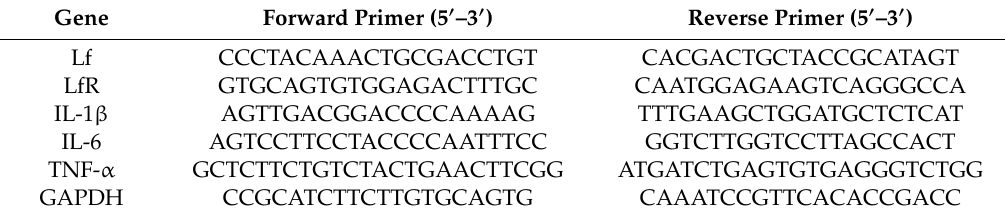
Table 1. Gene special primers used in the quantitative real-time PCR.